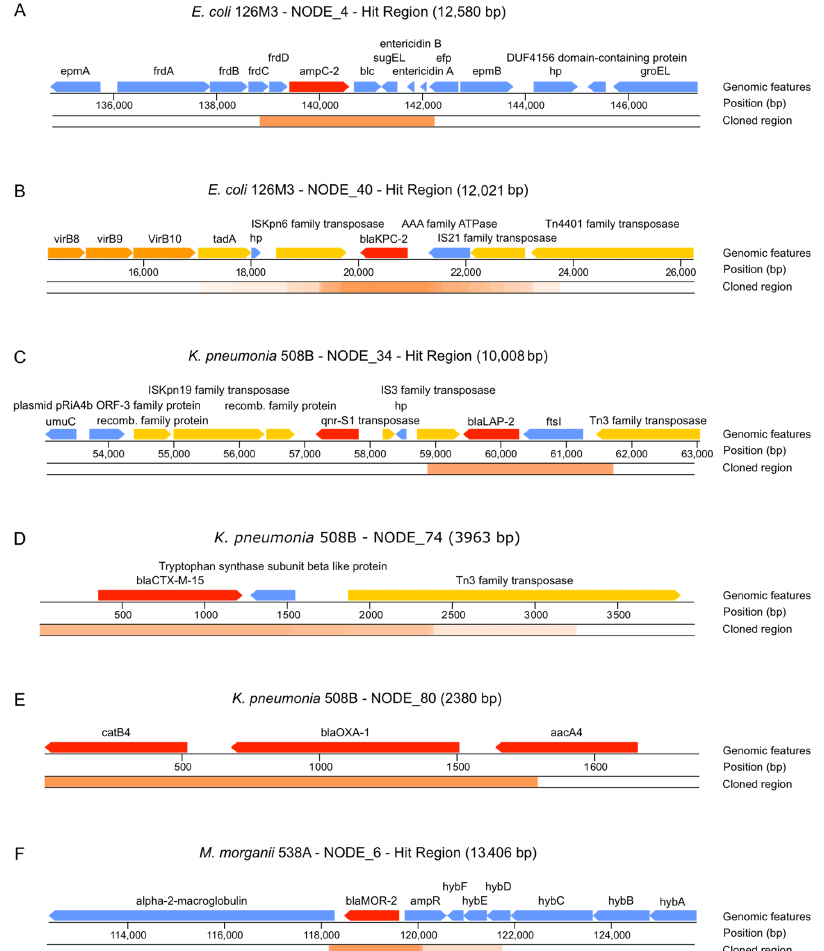
Figure 6. Features found in identified clones conferring resistance to antibiotics. ( A ) ampC-2 gene identified from E. coli 126M3. ( B ) bla KPC-2 gene identified from E. coli 126M3. ( C ) bla LAP-2 gene identified from pKP508BN34 plasmid from K. pneumoniae 508B. ( D ) blaCTX-M-15 gene identified from K. pneumoniae 508B. ( E ) bla OXA-1 gene identified from K. pneumoniae 508B. ( F ) bla MOR-2 gene identified from M. morganii 538A. ORFs are colored according to their function: red—ORFs directly related to antibiotic resistance; orange—ORFs related to virulence; yellow—ORFs related to horizontal transfer of the ARG; blue—ORFs with no identified relation to pathogenesis. The cloned region represents contig regions that were identified in our screenings. Overlapping cloned regions are darker, while dim regions have fewer overlapping identified clones.